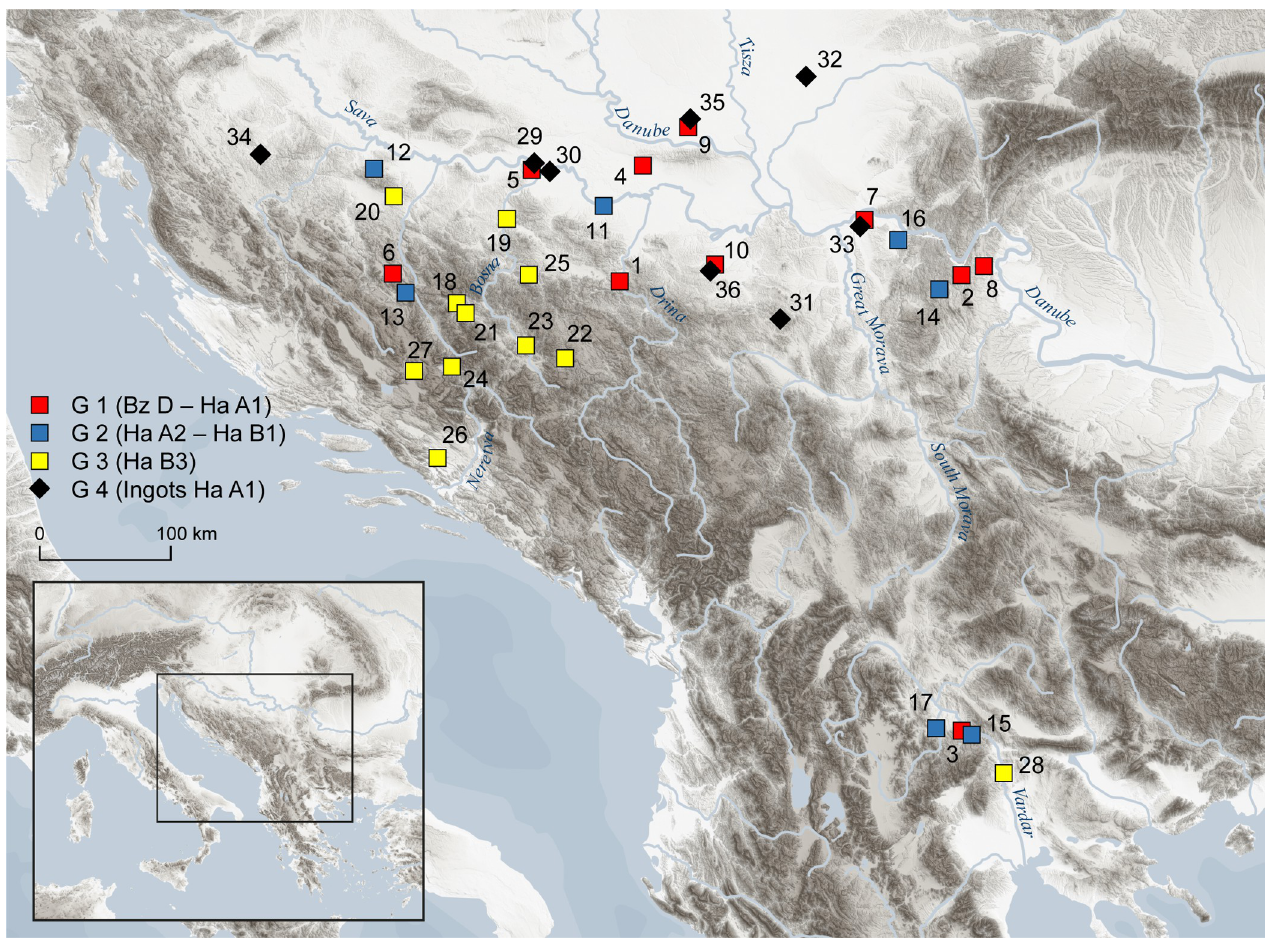
Fig 1. Map of the sites included in the presented analyses. 1: Radaljska Ada; 2: Topolnica; 3: Mali Dol; 4: Privina Glava; 5: Novigrad; 6: Antoni ć i; 7: Kli č evac- Rastova č a; 8: Urovica; 9: Futog; 10: Trli ć ; 11. Brezovo Polje; 12: Vojskova; 13: Drenov Do; 14: Leskovo; 15: Demir Kapija; 16: Vojilovo; 17: Sivec; 18: Travnik; 19: Grapska; 20: Ivanjska; 21: Veliki Mosˇunj; 22: Gradac-Sokolac; 23. Ilijasˇ; 24: Prozor; 25: Hrge-Lu č ica; 25: Vitina-Otok; 27: Pakline; 28: Milci; 29: Novigrad; 30: Topolovaca Bregovi; 31: Rudnik; 32: Hetin; 33. Kli č evac-Rastova č a; 34: Podzvid-Sˇumatac; 35: Futog; 36: Trli ć (Map made by I. Petschko, source digital elevation model: NASA JPL (2013). NASA Shuttle Radar Topography Mission Global 3 arc second [Data set]. NASA EOSDIS Land Processes DAAC. https://doi. org/10.5067/MEaSUREs/SRTM/SRTMGL3.003; vector data of water bodies: Natural Earth https://www.naturalearthdata.com (public domain). https://doi.org/10.1371/journal.pone.0263823.g001 PLOS ONE | https://doi.org/10.1371/journal.pone.0263823 March 11,